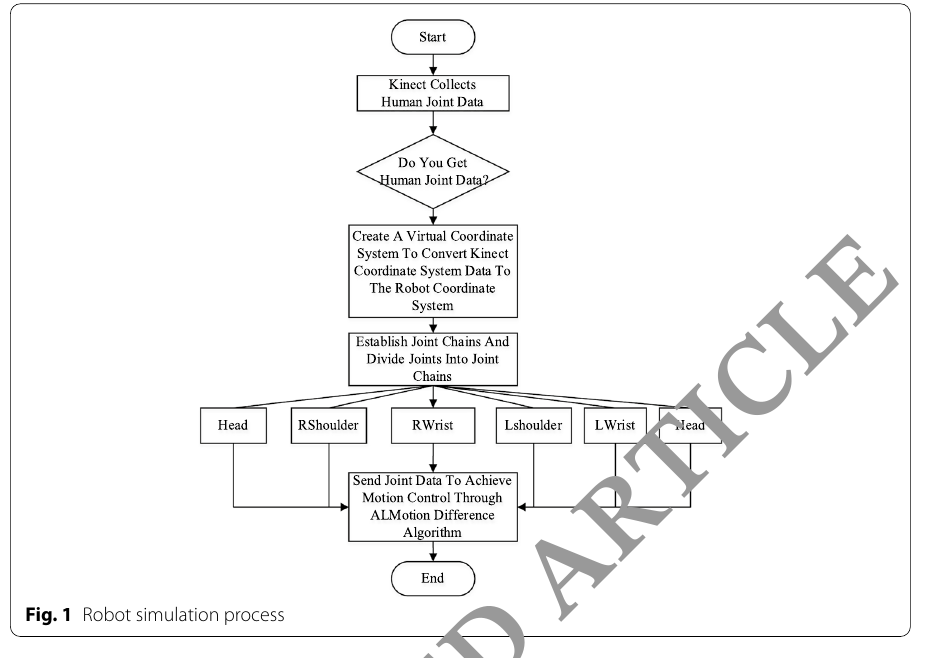
Fig. 1 Robot simulation